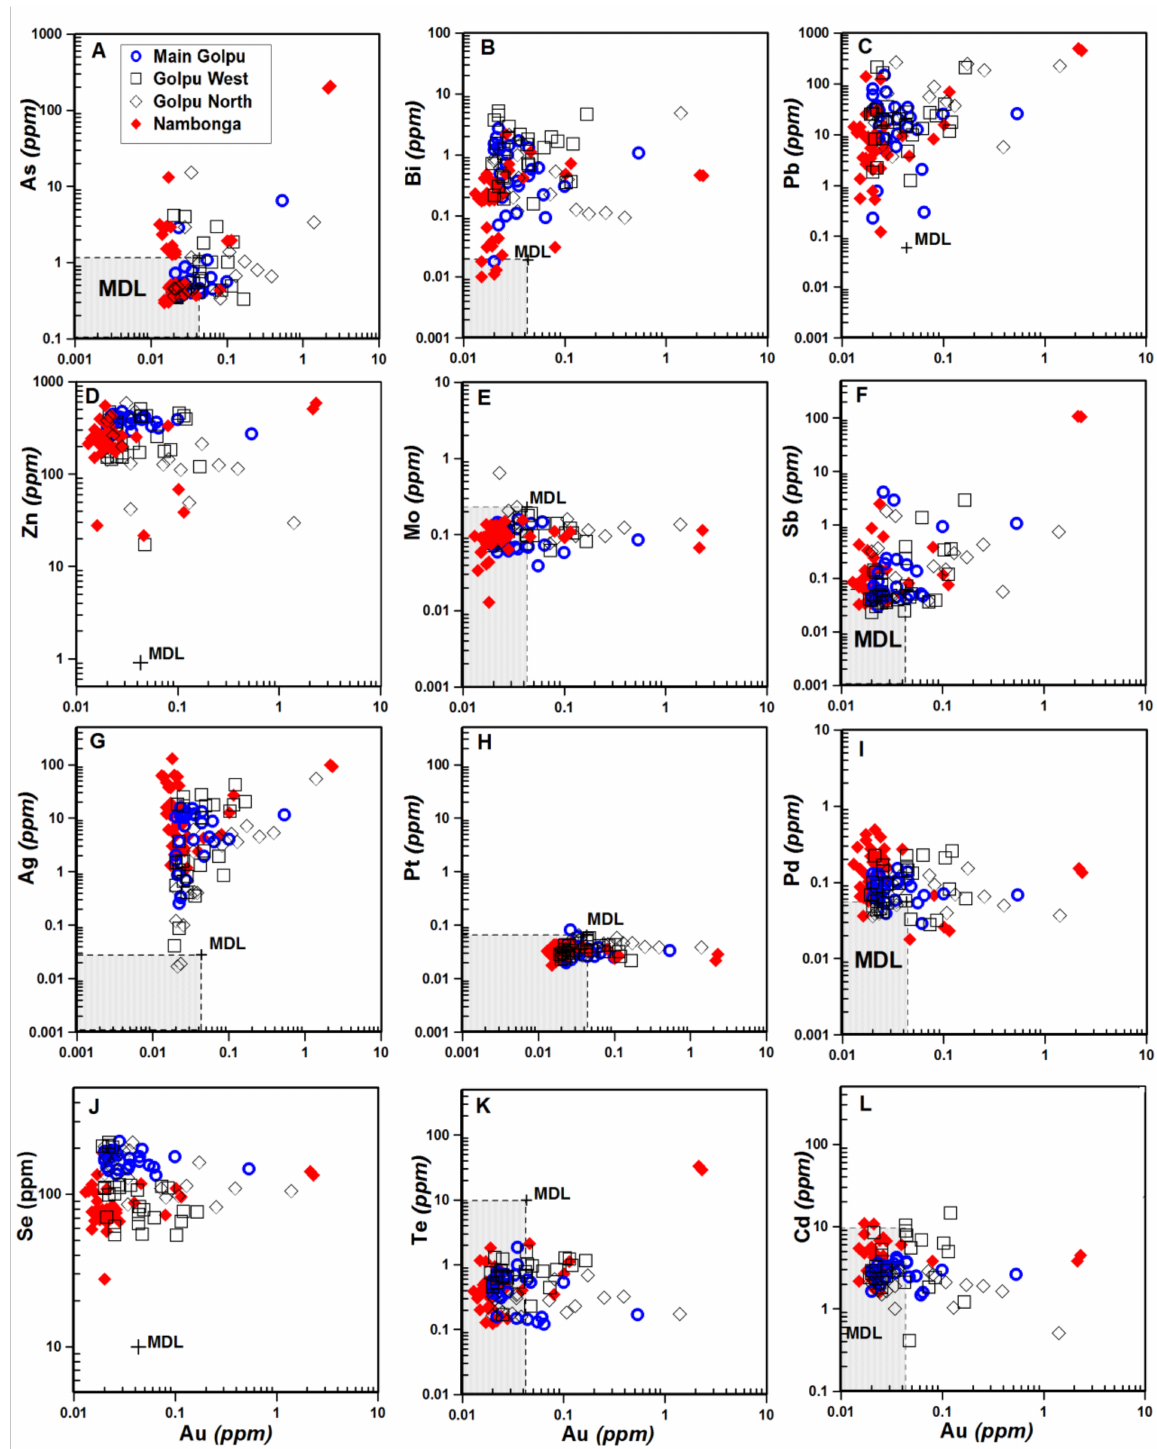
Figure 6. Log-plots of the trace element concentrations in the chalcopyrite samples from the Nambonga North and Golpu porphyries, ( A ) Au versus As, ( B ) Au versus Bi, ( C ) Au versus Pb, ( D ) Au versus Zn, ( E ) Au versus Mo, ( F ) Au versus Sb, ( G ) Au versus Ag, ( H ) Au versus Pt, ( I ) Au versus Pd, ( J ) Au versus Se, ( K ) Au versus Te, and ( L ) Au versus Cd. MDL is abbreviated for Minimum Detection Limit. The full results are shown in Appendix